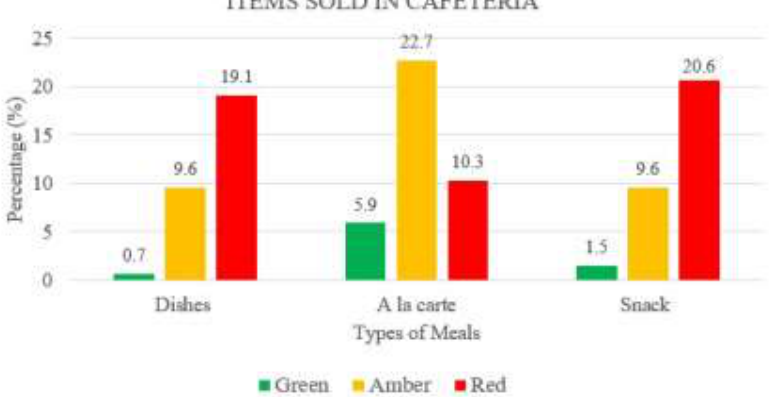
Figure 1: Traffic light profiling based on types of food items sold in the cafeteria.